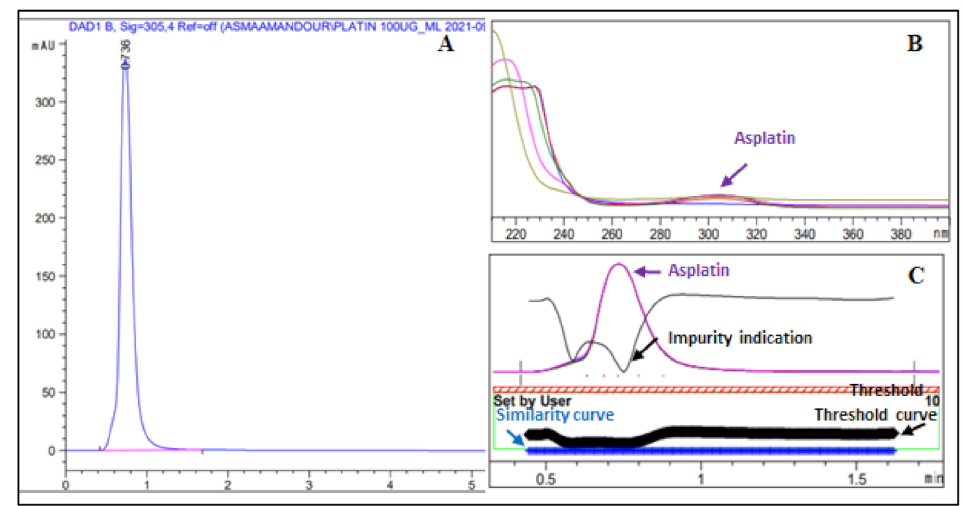
Figure 2. ( A ) UHPLC chromatogram of asplatin 100 µ g/mL (0.2 mM), retention time of 0.736 min. ( B ) UV Spectrum at λ max 305 nm showing similarity of absorbances of asplatin (purple line) containing impurities with a purity factor of about 900 showing spectral similarity. ( C ) Similarity (blue) and threshold (black) curves show asplatin’s impurity content within the threshold limit (in the green